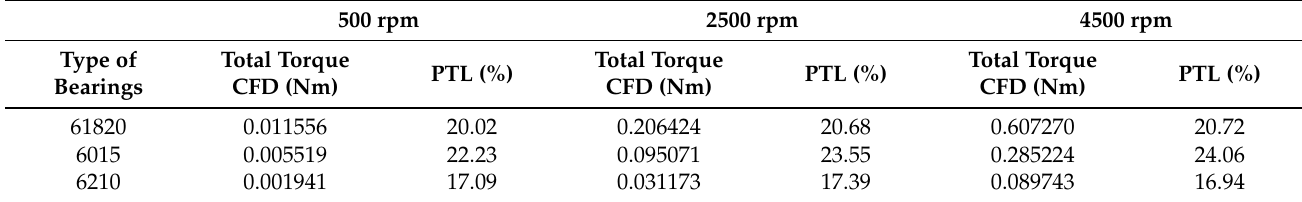
Table 4. Results of transient CFD simulations for hubs in water.